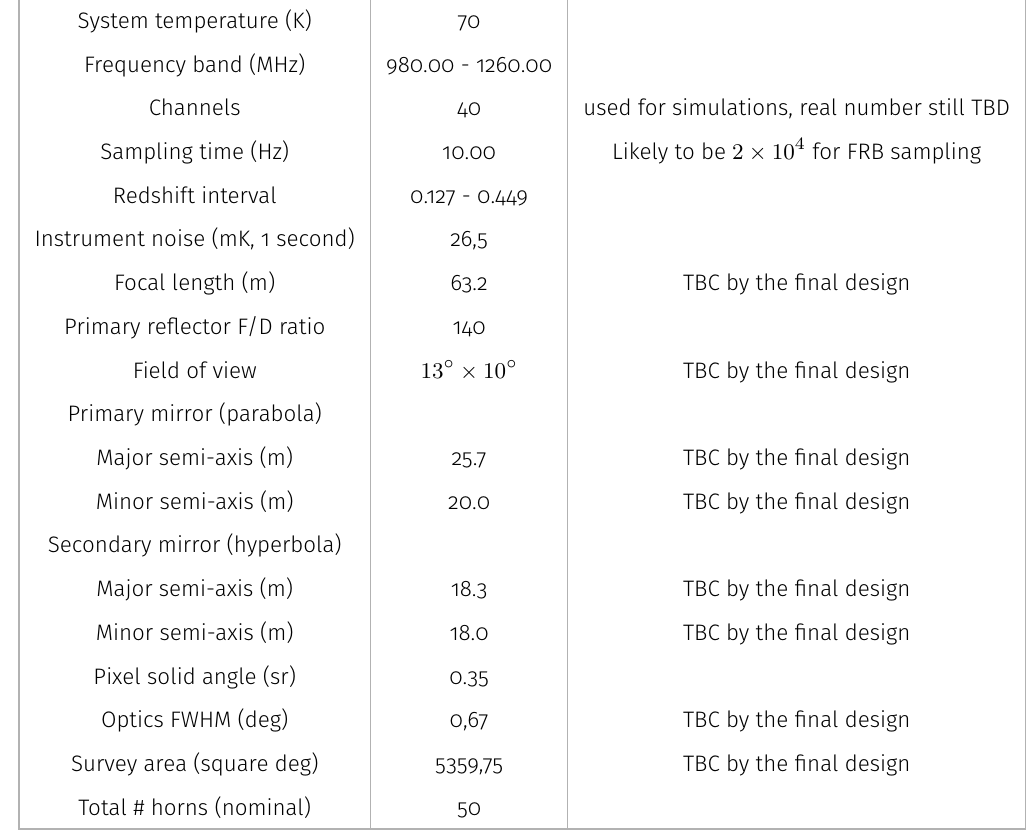
Table I. BINGO telescope parameter